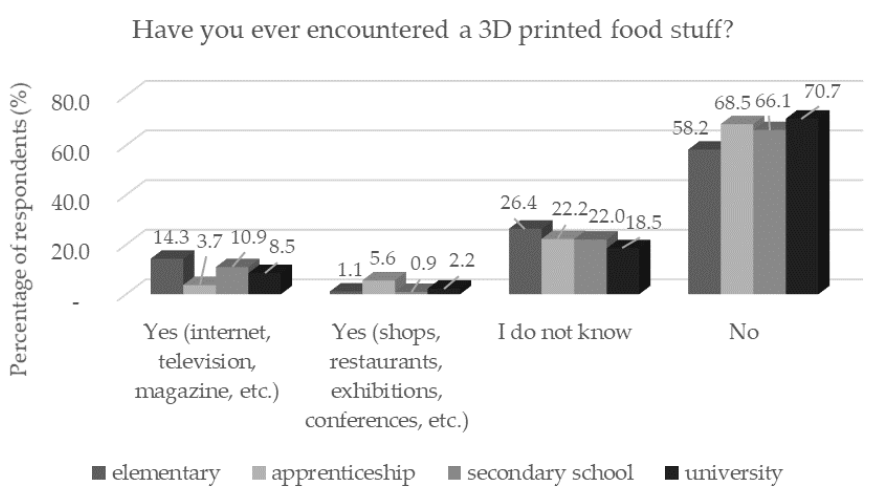
Figure 3. Respondents’ awareness of 3D food printing ( n = 1156) by education in response to the question: “Have you ever encountered 3D printed food stuff?”